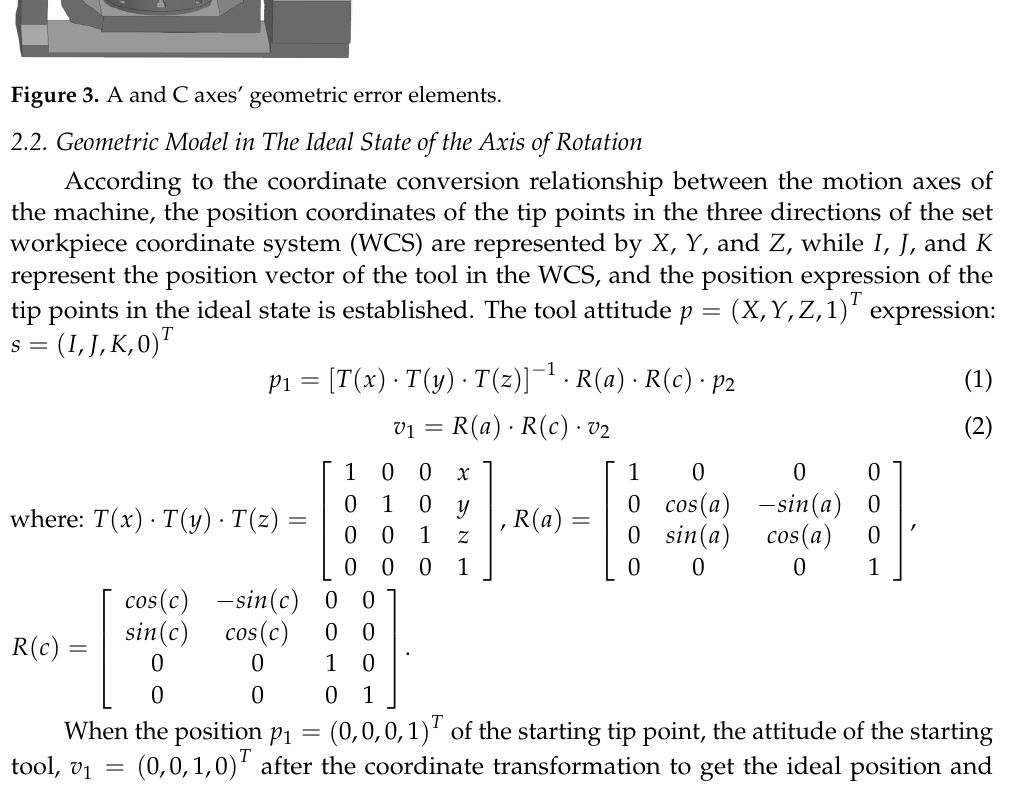
Table 1. Various geometric error elements of A and C axes. Shaft Corner Error Movement Error